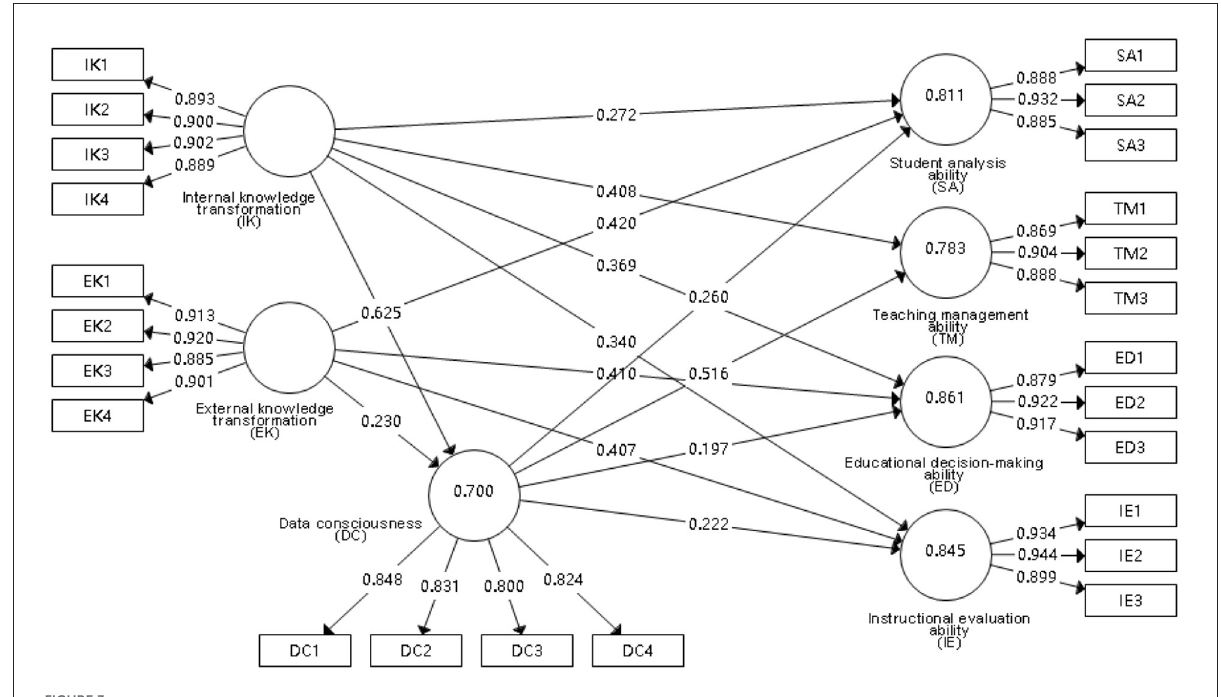
FIGURE3 Revised theoretical model and path